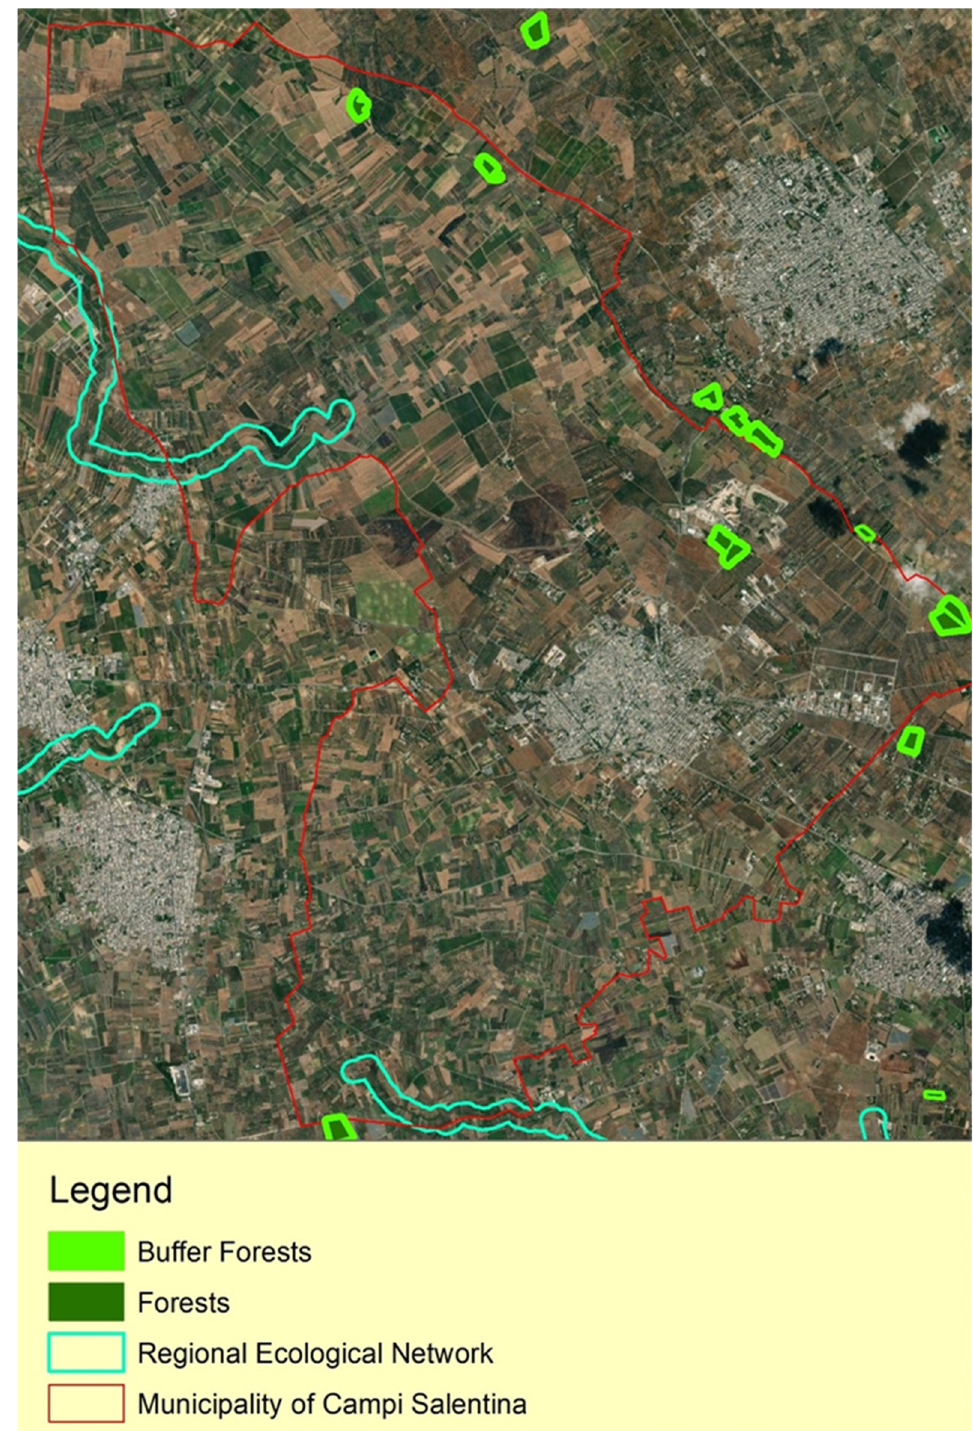
Figure 3. Landscape Elements of interest protected under the Puglia Regional Landscape Plan [44].